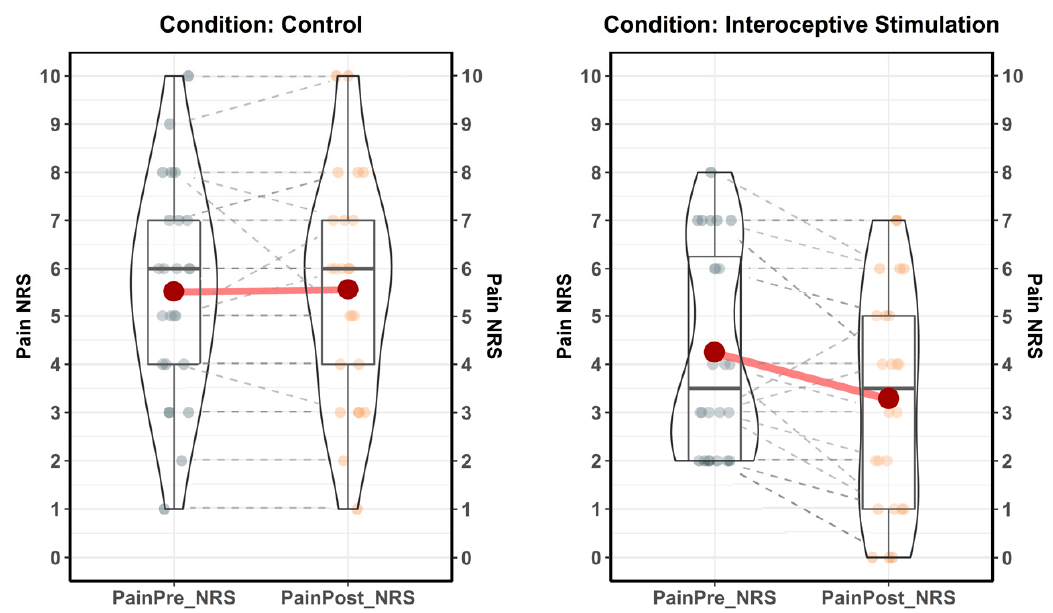
Figure 6. Interoceptive stimulation reduces Chronic Pain. In the control condition, CP patients ( N = 25) received control tactile pressure stimulation at 100 mN. In the experimental condition, CP patients ( N = 24) received interoceptive tactile stimulation at 3 cm / s with a force of 2.5 mN. Red dots represent mean values. Control condition, PainPre_NRS µ = 5.52, CI 95% (4.6, 6.44), PainPost_NRS µ = 5.56, CI 95% (4.6, 6.52). Interoceptive stimulation condition, PainPre_NRS µ = 4.25, CI 95% (3.35, 5.15), PainPost_NRS µ = 3.29, CI 95% (2.33, 4.25).